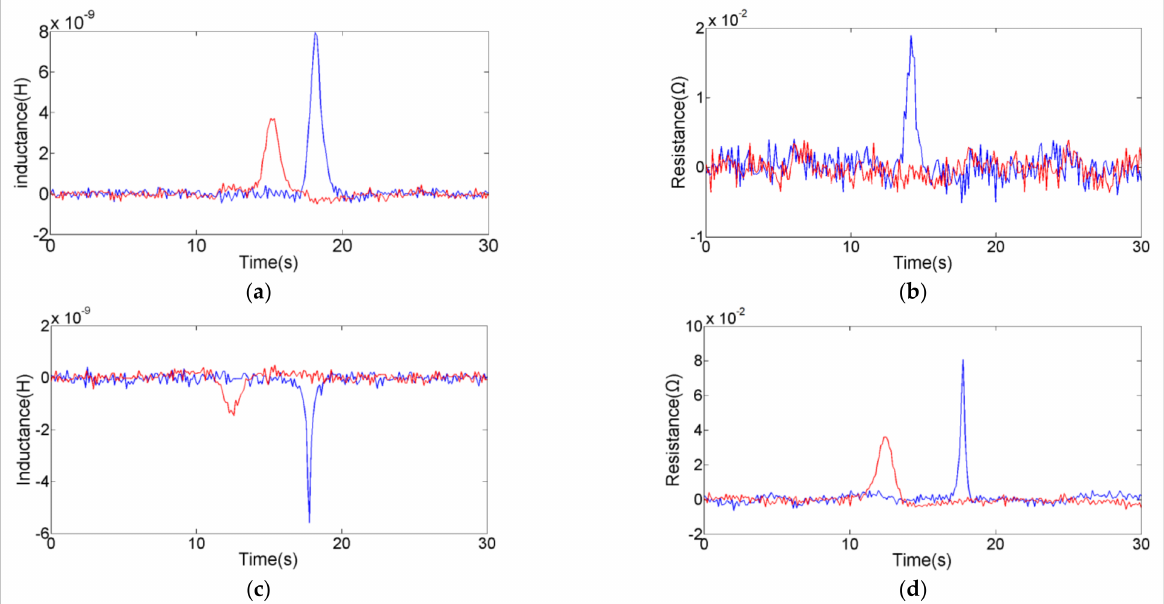
Figure 6. Detection results of coils in series; red signal is the result of the sensing unit without silicon steel strips, blue signal is the result of the sensing unit with silicon steel strips: ( a ) inductance pulse of 93 µ m iron particle; ( b ) resistance pulse of 93 µ m iron particle; ( c ) inductance pulse of 186 µ m copper particle; ( d ) resistance pulse of 186 µ m copper